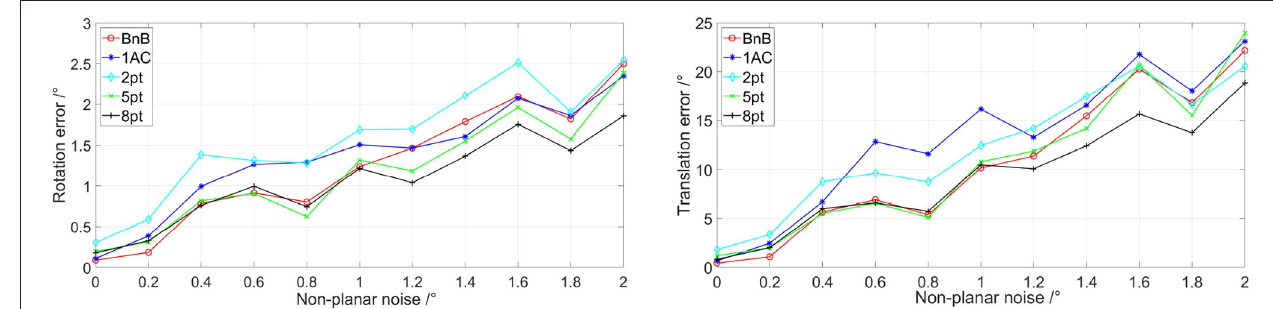
FIGURE 3 | Evaluations of five algorithms on different non-planar noise. The image noise is set as σ = 0.5. The left image shows rotation error with different non-planar noise and the right one represents translation error with different non-planar noise. 1AC, 2pt, 5pt, and 8pt are the studies of Hartley and Zisserman (2003); Nistér (2004); Choi and Kim (2018); Guan et al. (2020), respectively, and BnB is our study. Better viewed in color.